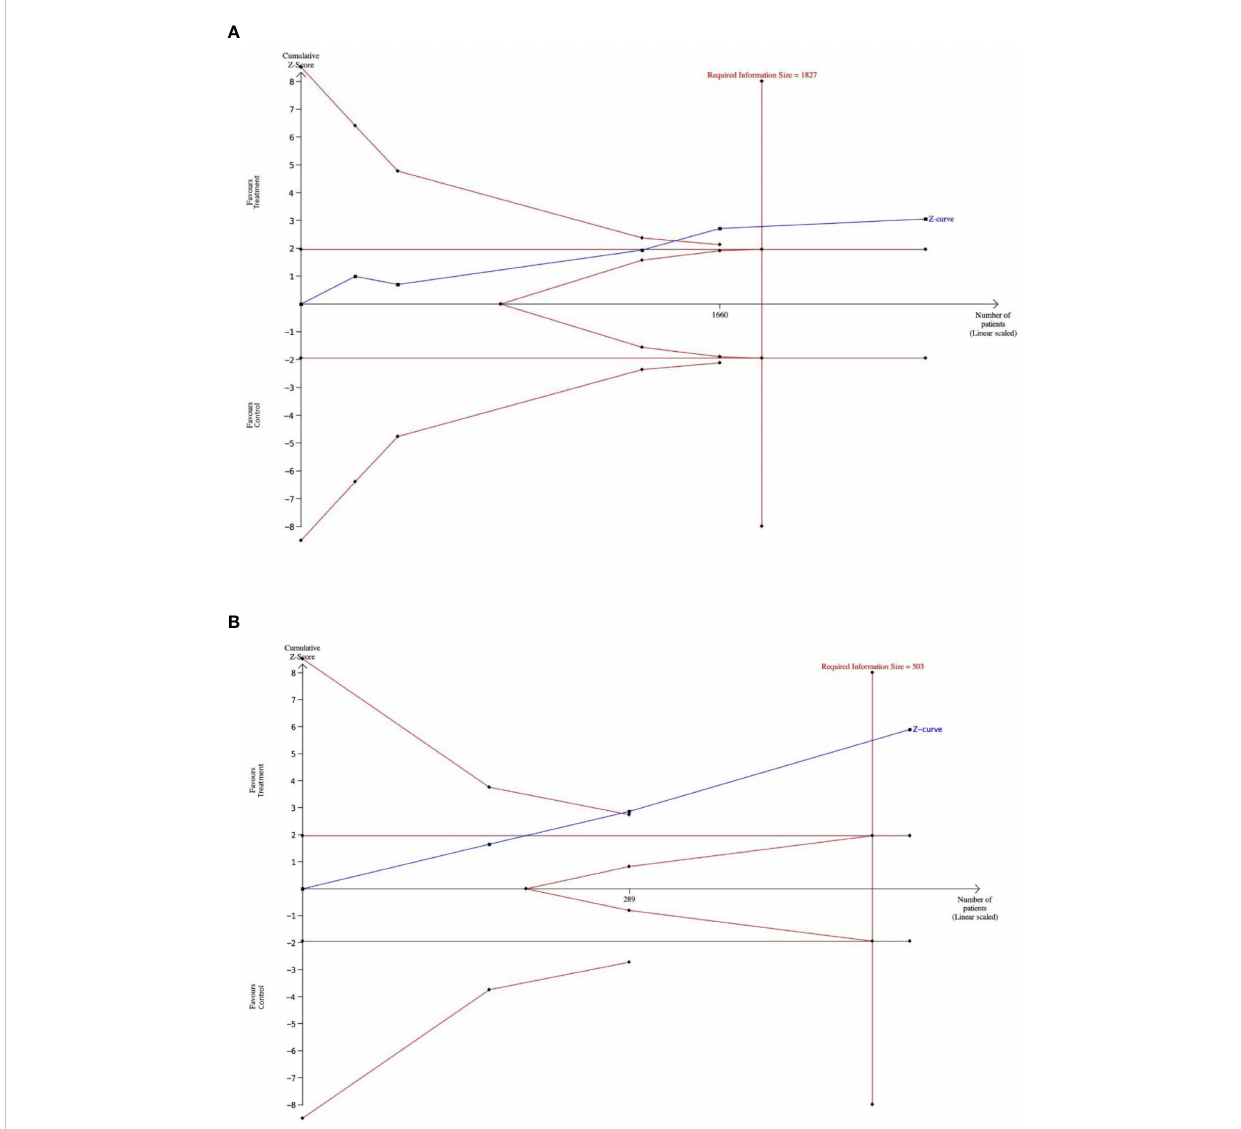
FIGURE 4 (A) . The outcome of a trial-sequential analysis comparing the rates of diverticulitis episodes in patients receiving primary prophylaxis with rifaximin versus patients who did not receive rifaximin. The diversity-adjusted required sample size (1,827 participants) was based on an alpha error of 5% and a beta error of 20. Cumulative z-curves were computed by a fi xed effects model. (Alpha-boundaries are the external red lines) (B) . The outcome of a trial-sequential analysis comparing diverticulitis relapse rates in patients receiving secondary prophylaxis with rifaximin versus patients not